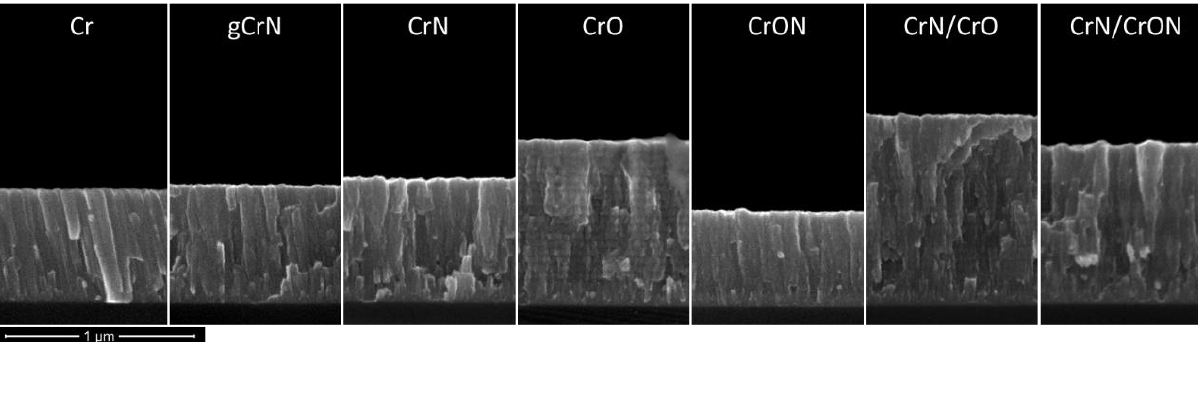
Figure 4. Scanning electron cross-section micrographs of the coatings deposited on silicon.